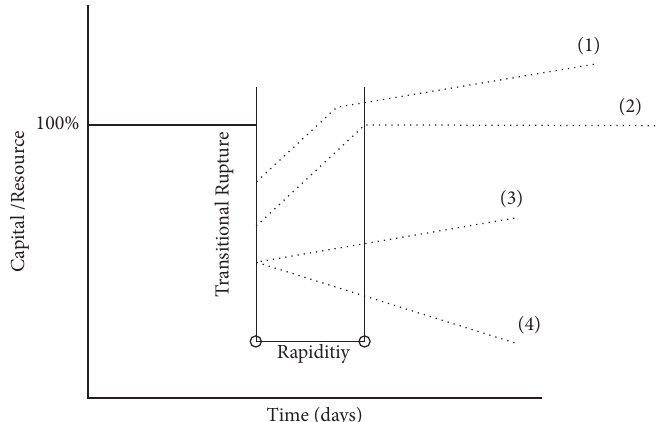
Figure 1: Resilience concept in the